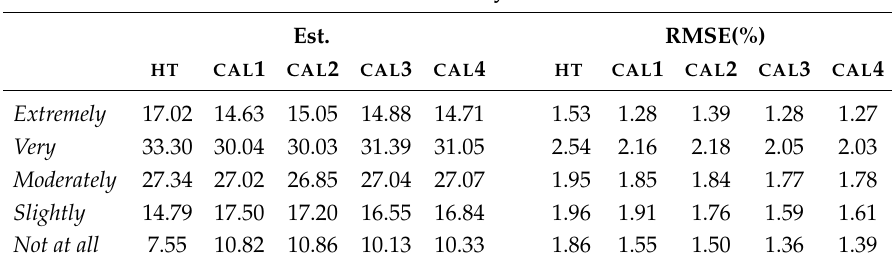
Table 7. Point estimation of proportions (in percent, %) using several methods: unweighted ( HT ), calibration in one ( CAL 1) or two stages ( CAL 2, CAL 3 and CAL 4). Main variable:“Preferences for political decisions” . Estimated Root Mean Squared Error using jackknife.